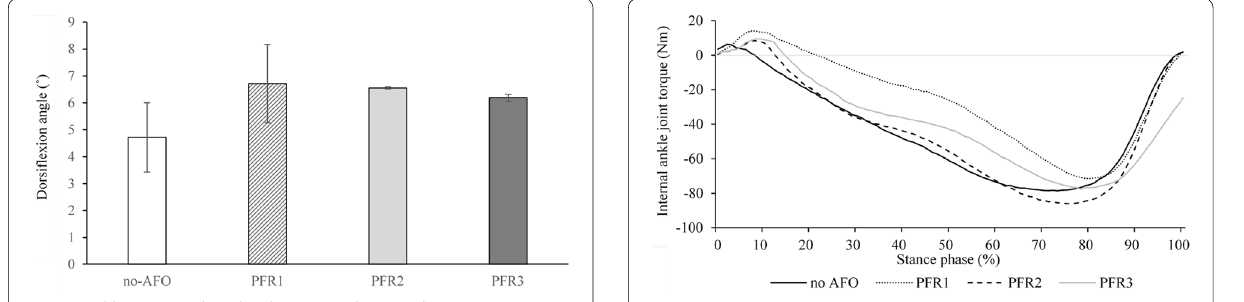
Fig. 4 Ankle joint angle in heel contact. The error bars represent standard deviation from the mean